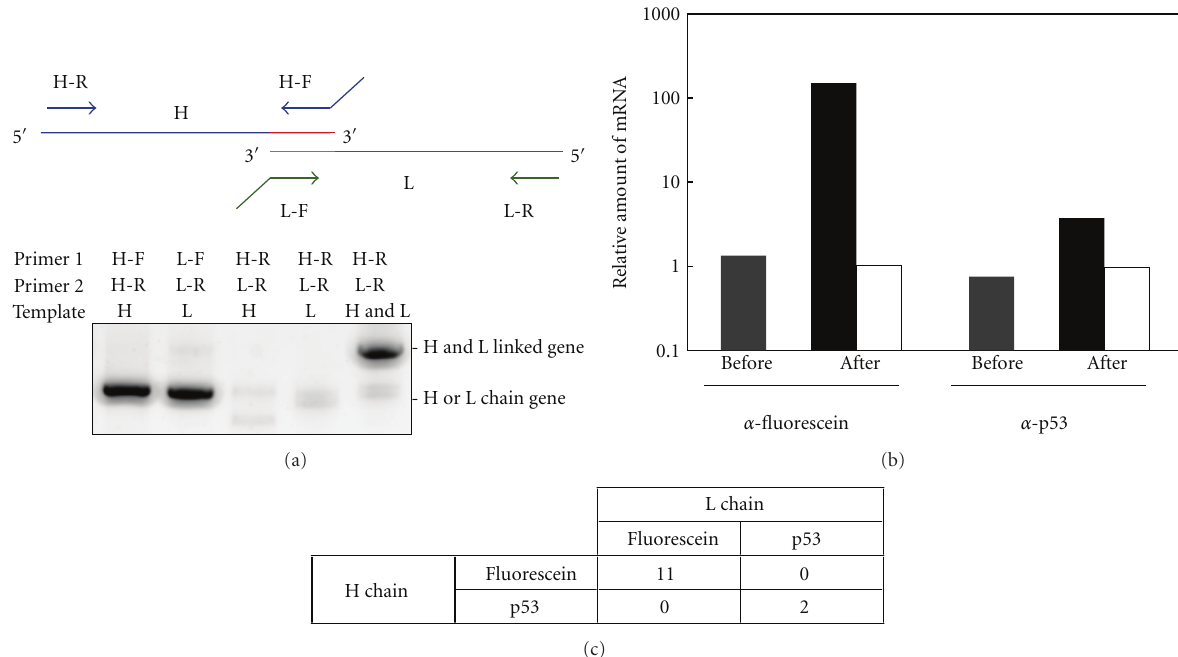
Figure 3: Model experiments of in vitro selection of Fab fragments using mRNA display and emulsion PCR. (a) Confirmation of the H and L chain gene linking by PCR. The H chain or/and L chain gene of anti-fluorescein Fab fragments were amplified by PCR with forward and reverse primers of the corresponding gene or only reverse primers of both genes and analyzed on a 1.5% agarose gel. Primers H-F, H-R, L-F and L-R are UnivOL1-F, Myc-R, UnivOL2-F, and FLAG-R, respectively (Table 1). (b) Antigen-specific enrichment of mRNA-displayed Fab fragments. A single round of a ffi nity selection was carried out for antigen-immobilized and nonimmobilized beads from a mixture of equally amounted anti-p53 and anti-fluorescein Fab fragment genes. The amount of each gene before and after selection was quantified by quantitative PCR. The amount of the positive control gene divided by that of the negative control gene is plotted for both before selection (gray) and after selection by antigen-immobilized bead (black) and nonimmobilized beads (white). (c) Confirmation of H and L chain gene linking by cloning and sequencing after a ffi nity selection. mRNA-displayed anti-fluorescein Fab fragments and mRNA-displayed anti-p53 Fab fragments were mixed in a ratio of 1:50 and then used for a ffi nity selection against fluorescein-immobilized beads. After selection, a total of 13 clones were sequenced, and the correspondence of the H and L chains was